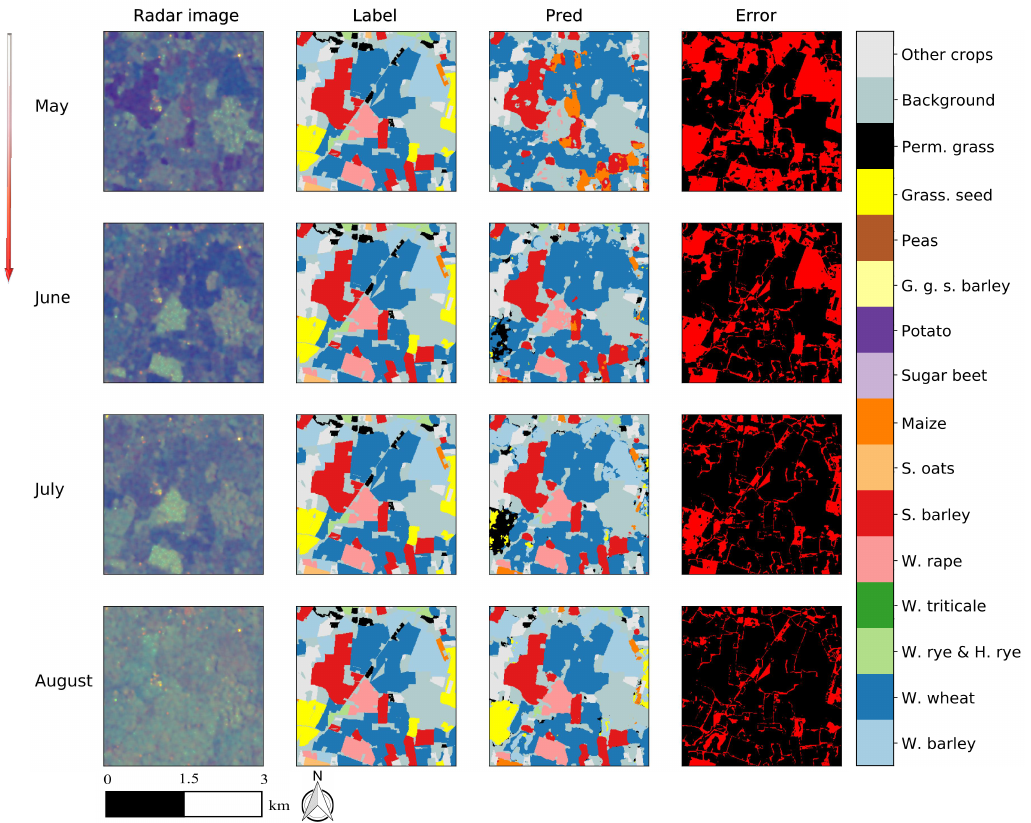
Figure 7. Qualitative results of the proposed sequential network (red pixels in the Error column represent the